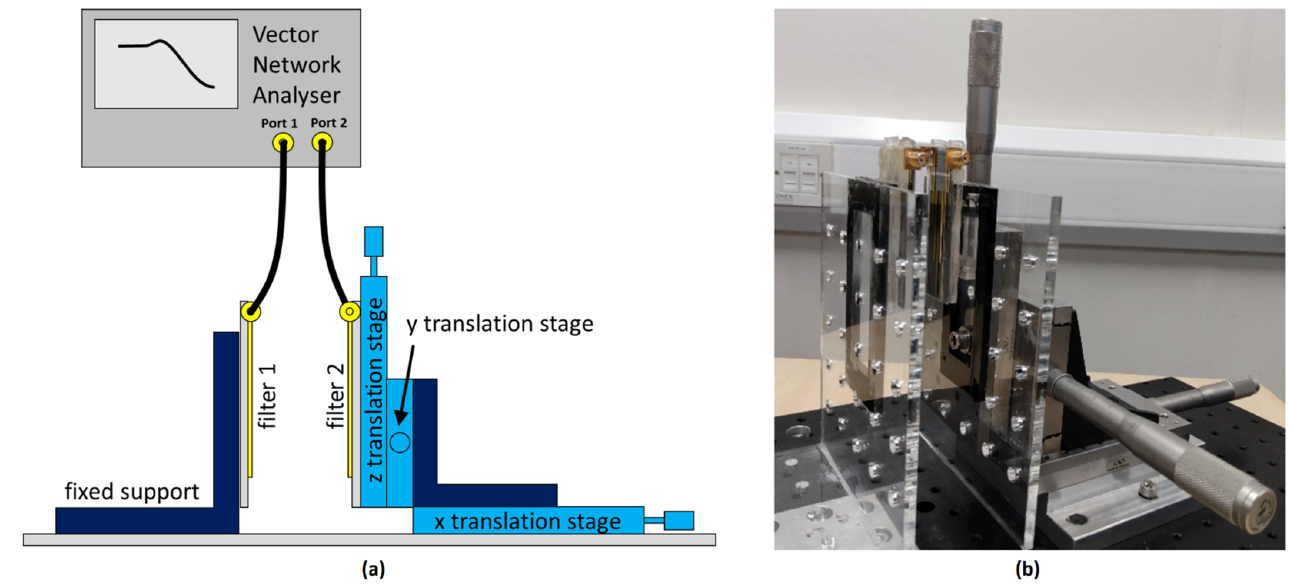
Figure 3. The band-pass filters and measurement set-up used for displacement-sensing characteri- sation. ( a ) Schematic of setup, ( b ) actual hardware implementation (VNA not connected). tion. ( a ) Schematic of setup, ( b ) actual hardware implementation (VNA not To simulate the motion or deformation of a structure of interest, the manual transla- tion stages were each sequentially adjusted from 0 mm to 15 mm in 1 mm steps, before being returned to their starting position. At each position, S 11 scans were taken over the scan range. The procedure was repeated, to obtain S 21 traces. As shown in Figure 3, S 11 was taken across filter 1, with filter 2 acting simply as a shielding plane. For S 21 measurements, the measurements were taken from the input side of filter 1 to the output side of filter 2.